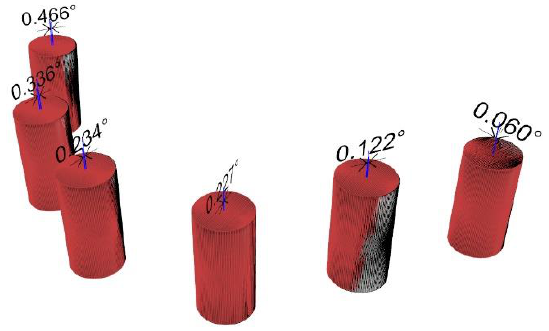
Figure 10. Angular deviation between the digitalized and original scan abutment position (four-implant impression), calculated along the long axis of each scan abutment after superimposition.